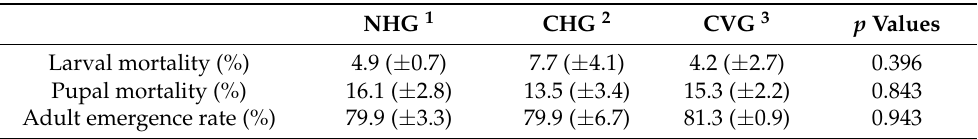
Table 3. Larval mortality, pupal mortality, and adult emergence rate in Apis mellifera . Values are means ± SE. No significant differences in mortalities and emergence rates were found among the three groups (chi-square test, p > 0.05).